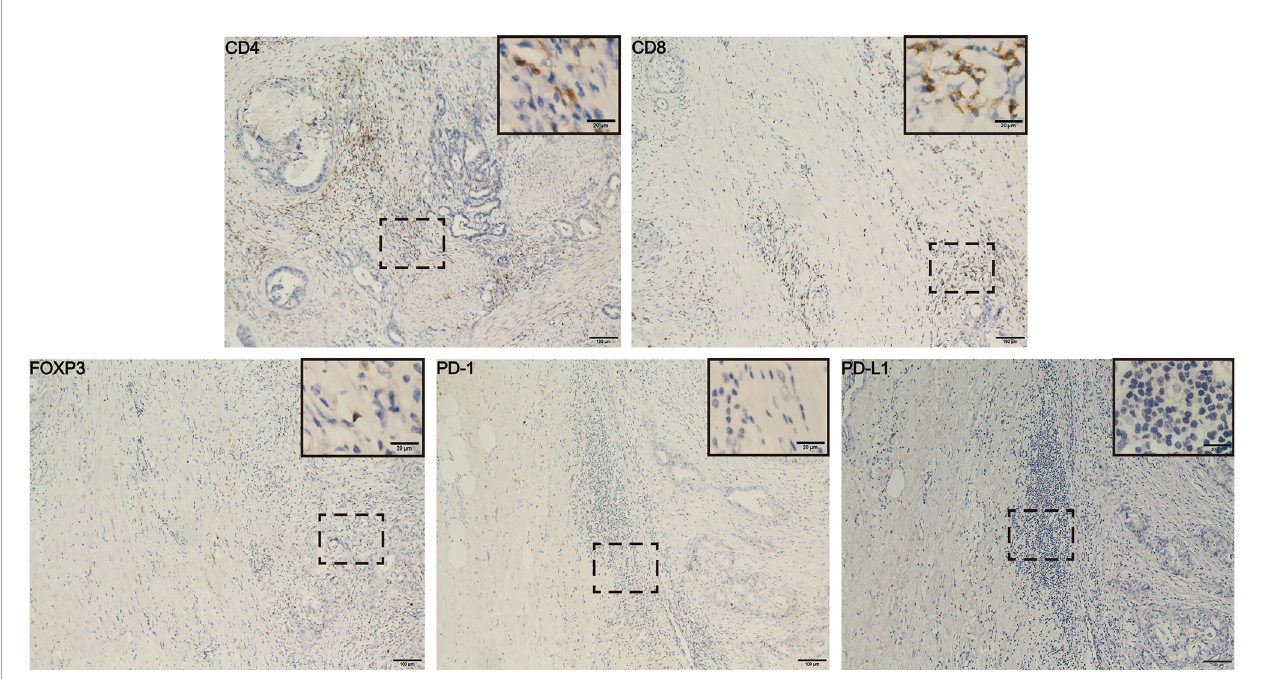
FIGURE 3 | Immunohistochemical results from post-operative pathological tissues of the patient. The results showed higher number of CD4 + and CD8 + T cells and the lower number of FOXP3 + Tregs and PD-(L)1 expression in tumor microenvironment. Scale bars represent 100 µm (20 µm in the inset images). FOXP3, Forkhead box P3; PD-L1, programmed cell death-ligand